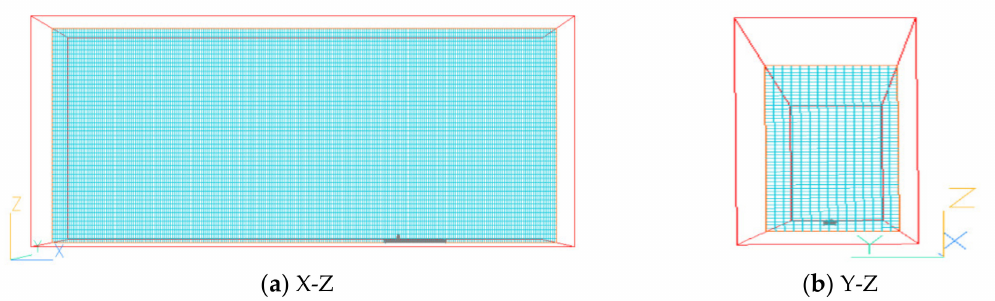
Figure 1. The ship model, the domain, and the grids in CFD: ( a ) model setting on the X–Z plane; ( b ) model setting on the Y–Z plane.